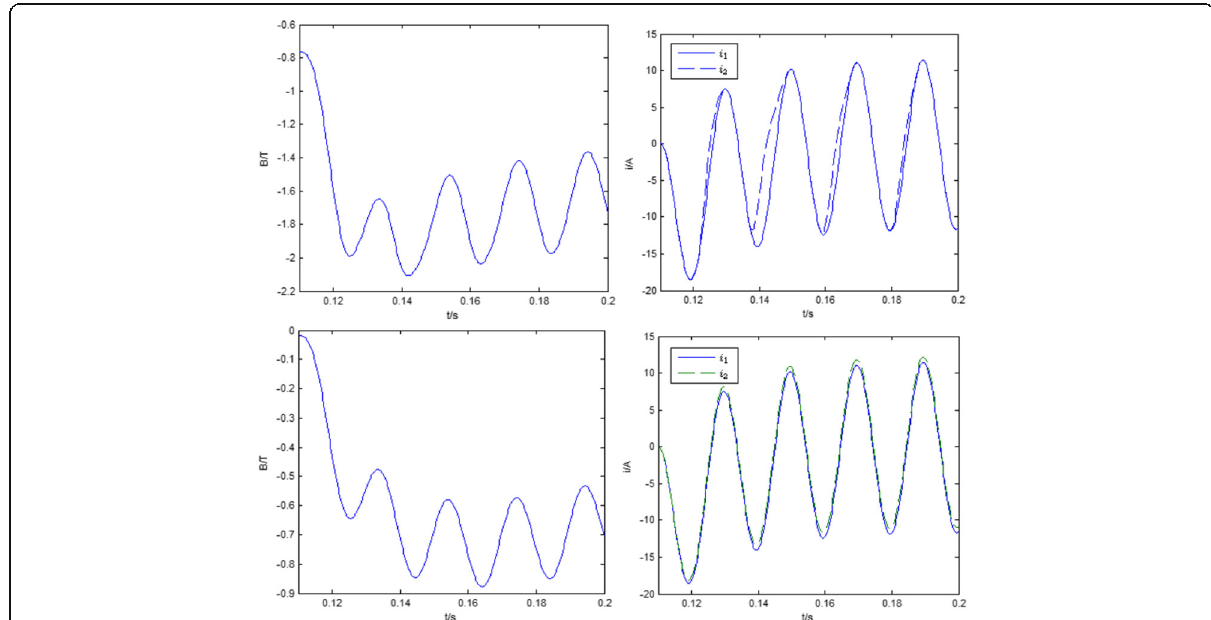
Fig. 17 -50% remanence, magnetic flux generated at fault occurring time is negative